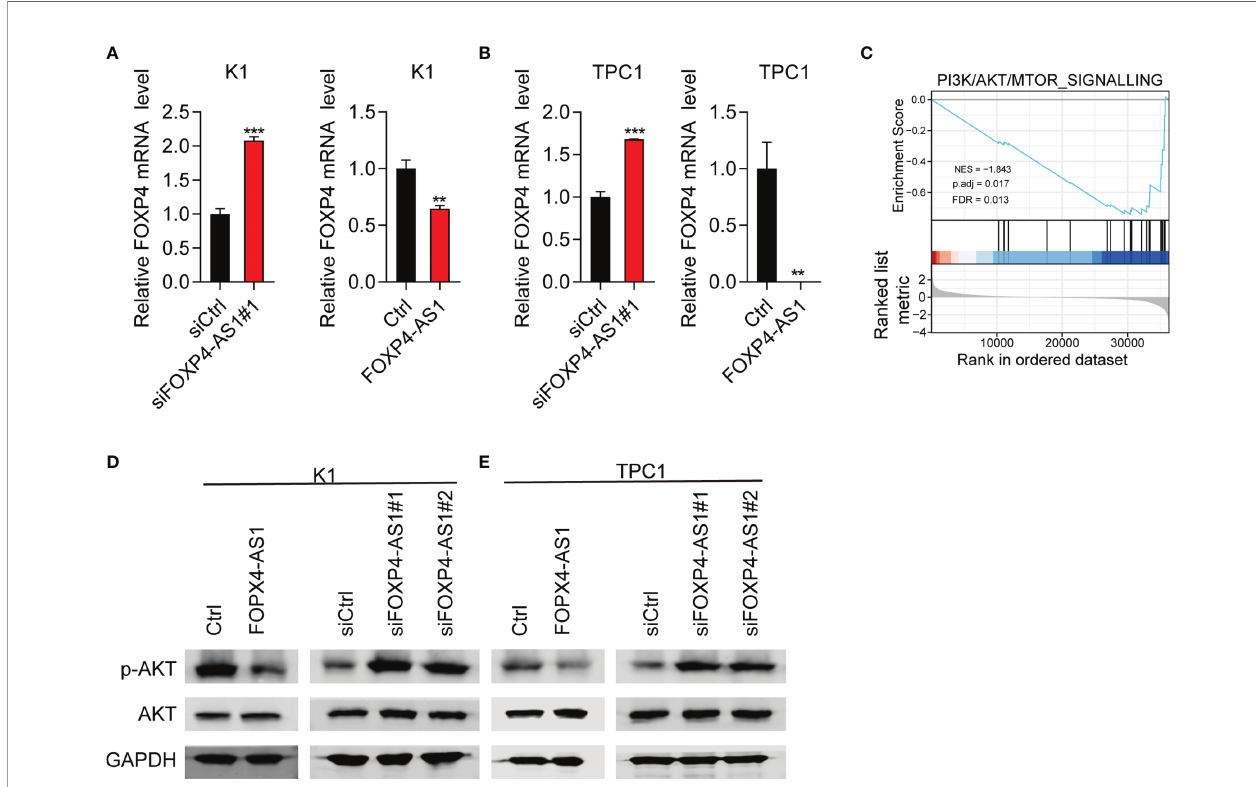
FIGURE 6 | FOXP4-AS1 can reverse-regulate FOXP4 expression and inhibit the activity of p-Akt. (A, B) The mRNA level of FOXP4 in (A) K1cell and (B) TPC-1 cell FOXP4-AS1 knockdown or overexpression was detected by RT-qPCR. (C) PI3K/AKT signaling pathway was enriched according to GSEA analysis. (D, E) The protein level of p-AKT in (D) K1 and (E) TPC-1 cells after knockdown of FOXP4-AS1 or overexpression was detected using western blot method. ** p < 0.01, *** p